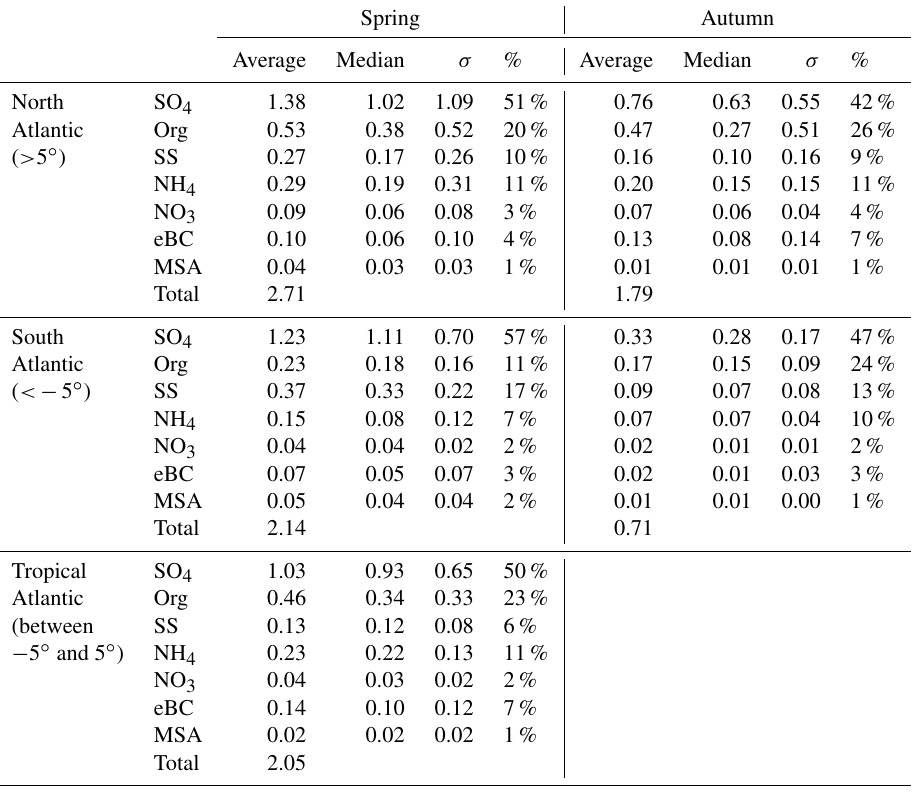
Table 3. Seasonal chemical composition of measured submicron aerosol particles over the Atlantic (µgm − 3 ).